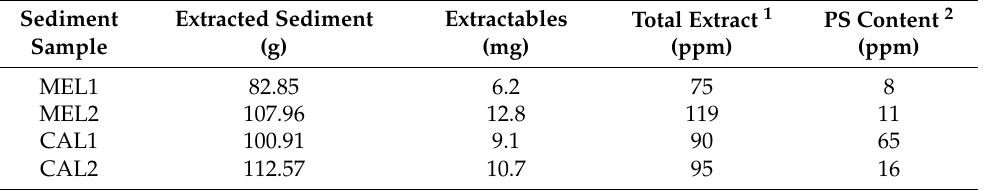
Table 3. Extractable fraction in DCM from the sediment samples.